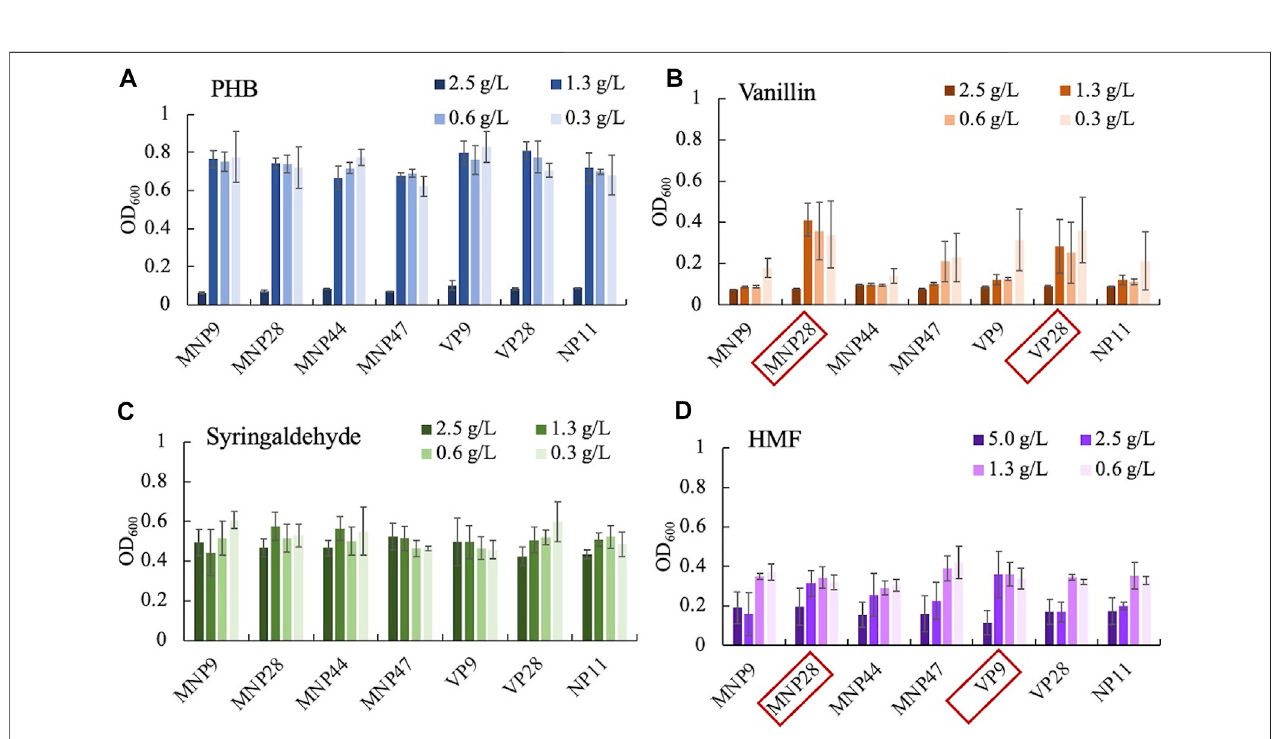
FIGURE 2 | Growth of dominant strains and the control under gradient concentrations (g/L) of PHB-p-hydroxy benzaldehyde (A) , vanillin (B) , syringaldehyde (C), and HMF-hydroxymethyl furfural (D) . Initial OD 600 was controlled at 0.2 by computer programming, and fi nal OD 600 was reached in 48 h. Red boxes represent the best growing strains selected for further test. Experiments were performed in